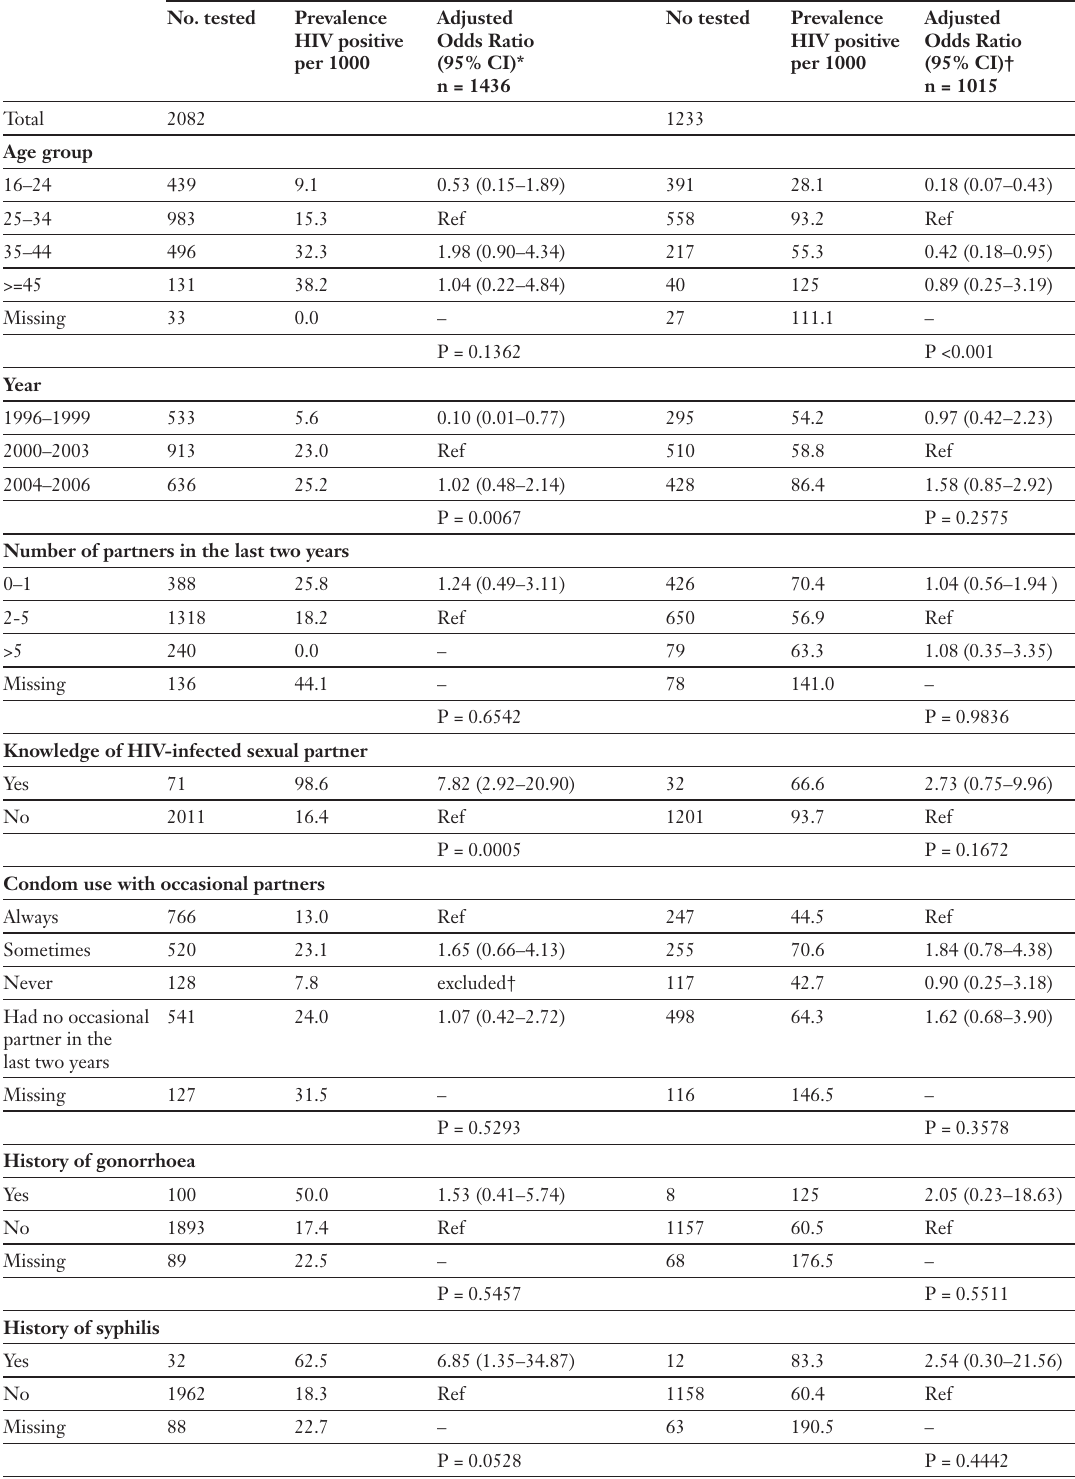
Stratified multivari- able logistic regres- sion analyses for African heterosexual clients at the five anonymous